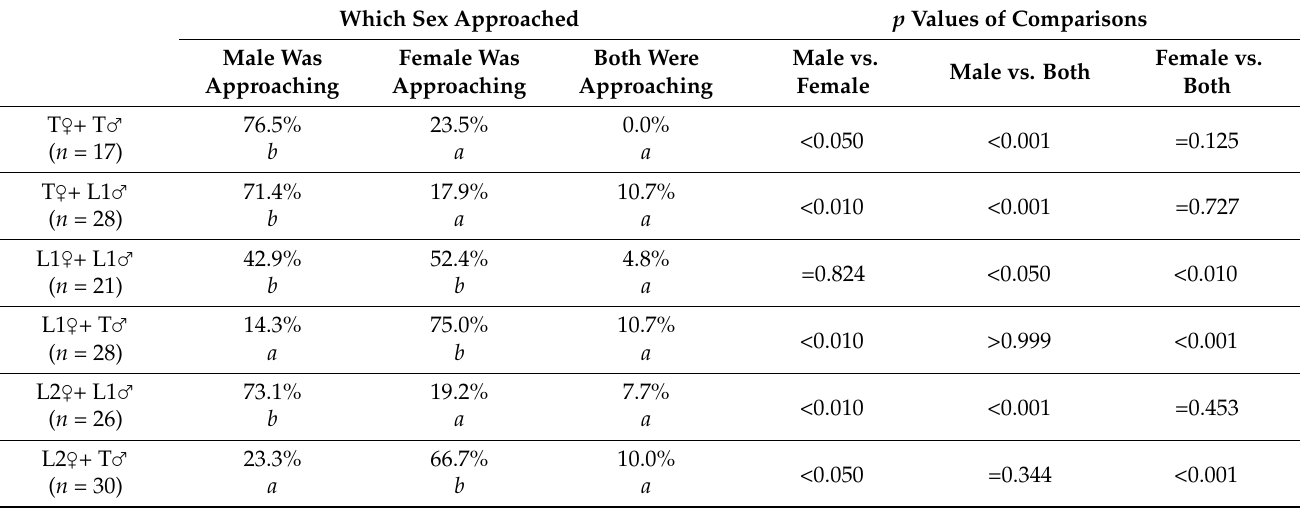
Table 6. Percentage of cases when the male or the female approached the other thrips, or both of them were moving to the other in the first interaction event for the six pairings. Which Sex Approached p Values of Comparisons Female vs. Female Was Both Were Male vs. Male vs. Both Approaching Approaching Female